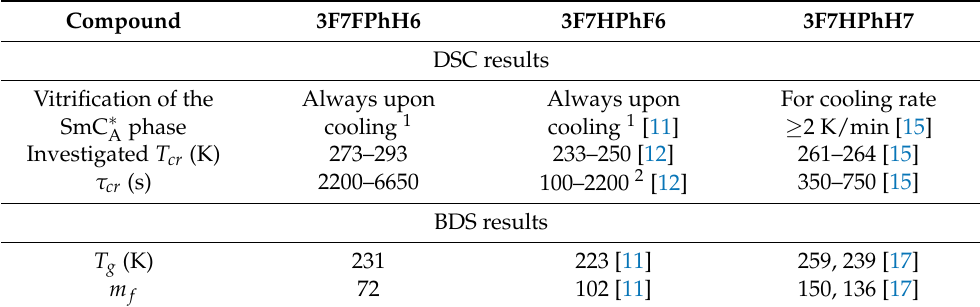
Table 4. Comparison of the glassforming properties and cold crystallization kinetics of 3F7FPhH6 presented in this paper and previously reported for the 3F7X 1 PhX 2 r compounds with almost identical molecular formulas. Compound 3F7FPhH6 3F7HPhF6 3F7HPhH7 DSC